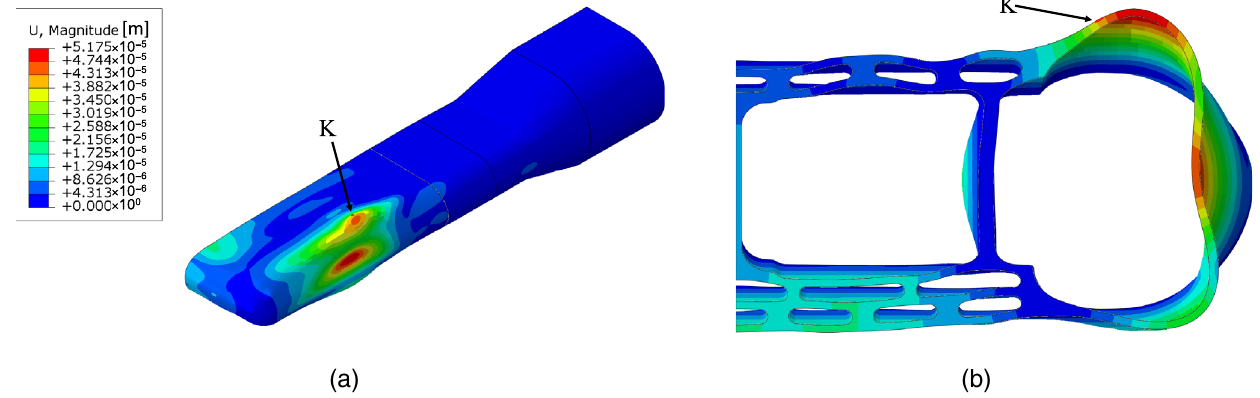
FIG. 22. Deformed shape (magnified 500 ×) of the front body at sensor K at 1.38 ms.